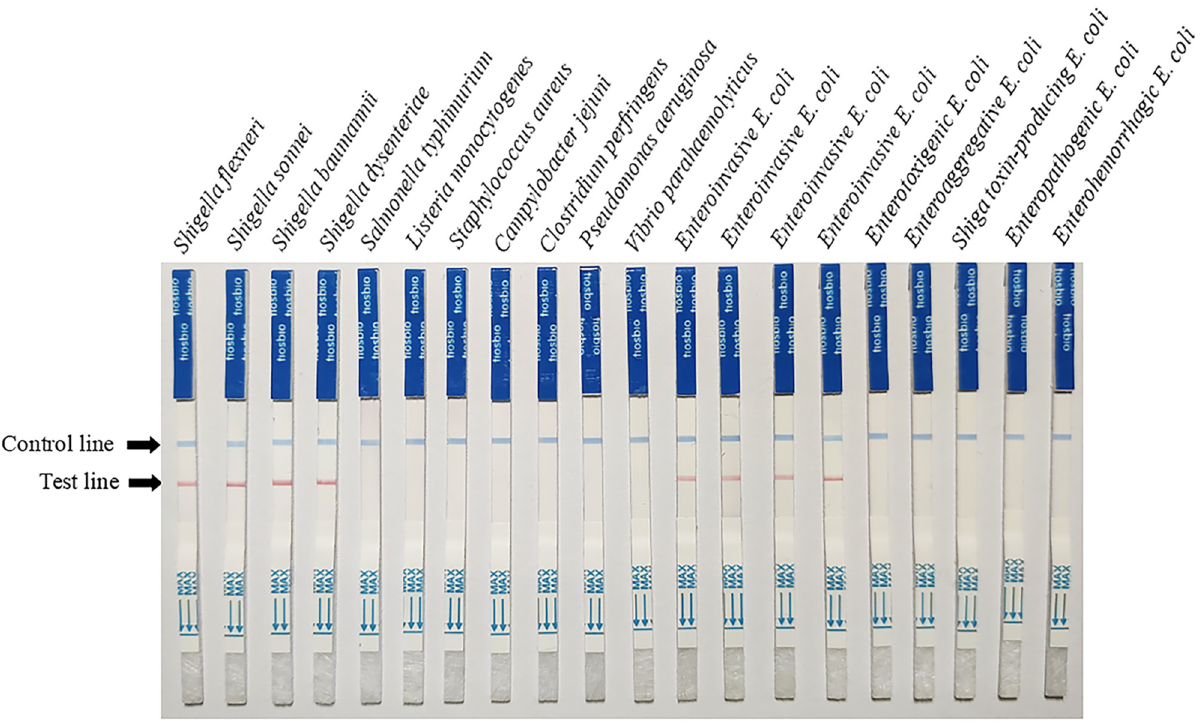
Fig 4. Specificity test for recombinase polymerase amplification combined with lateral flow test. Shigella and EIEC (the target strain) was tested against twelve different bacterial strains. A darkened test line indicates a positive result.